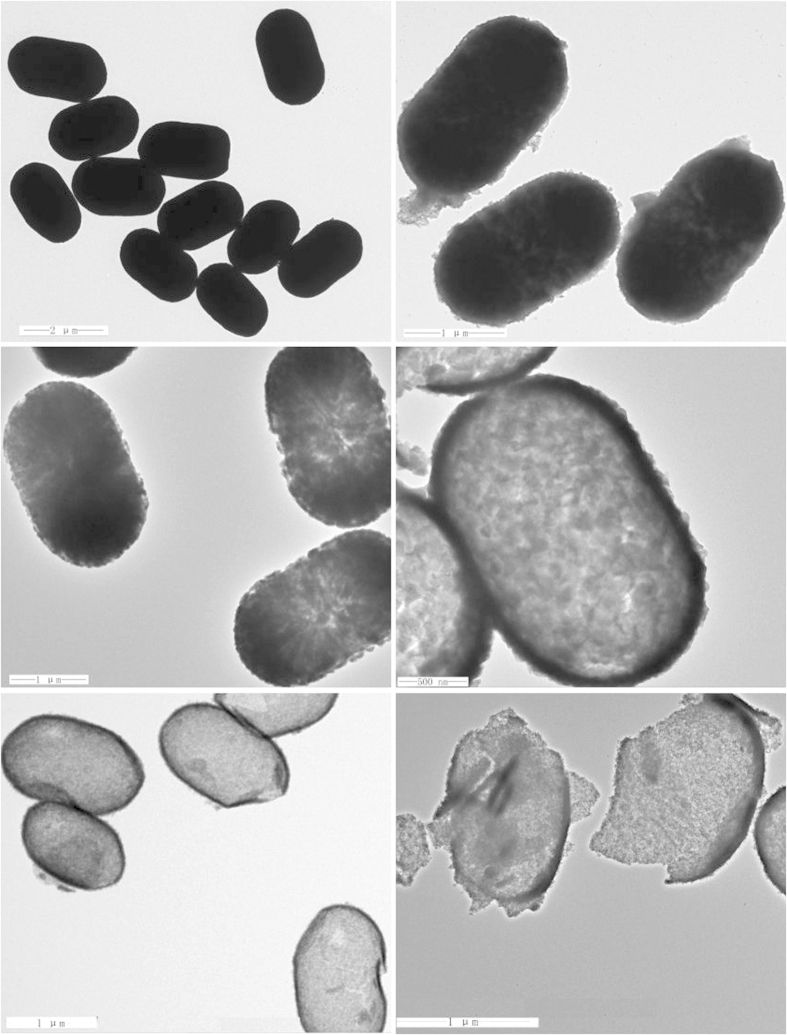
TEM images of hollow SnO2 nanocapsules obtained by etching of solid α-Fe2O3 particles at 100 °C for 0 min (a), 10 min (b), 20 min (c), 30 min (d), 40 min, and 50 min (f).